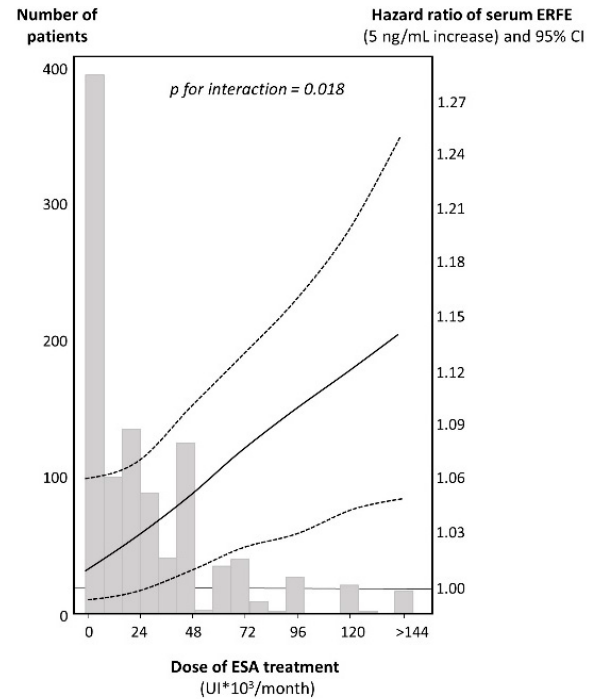
Figure 2. Interaction between ESA dose and serum ERFE levels for the risk of death and non-fatal CV events in HD patients. The hazard ratio for the combined end-point portended by a fixed increase (5 ng / ml) in serum ERFE levels is reported on the right scale. The continuous line represents the shape of the hazard ratios throughout the doses of ESA treatment and the dotted lines the corresponding 95% CI. In the background, the distribution of ESA doses is plotted, and the number of patients corresponding to each column of the histogram is reported on the left scale. Data are adjusted for age, sex, smoke, diabetes, cholesterol, blood pressure, background CV events, factors peculiar to ESKD (phosphate, hemoglobin, dialysis vintage, Kt / V, PTH), biomarkers of iron metabolism (serum ferritin and iron), and biomarkers of inflammation and nutritional status (CRP, albumin and